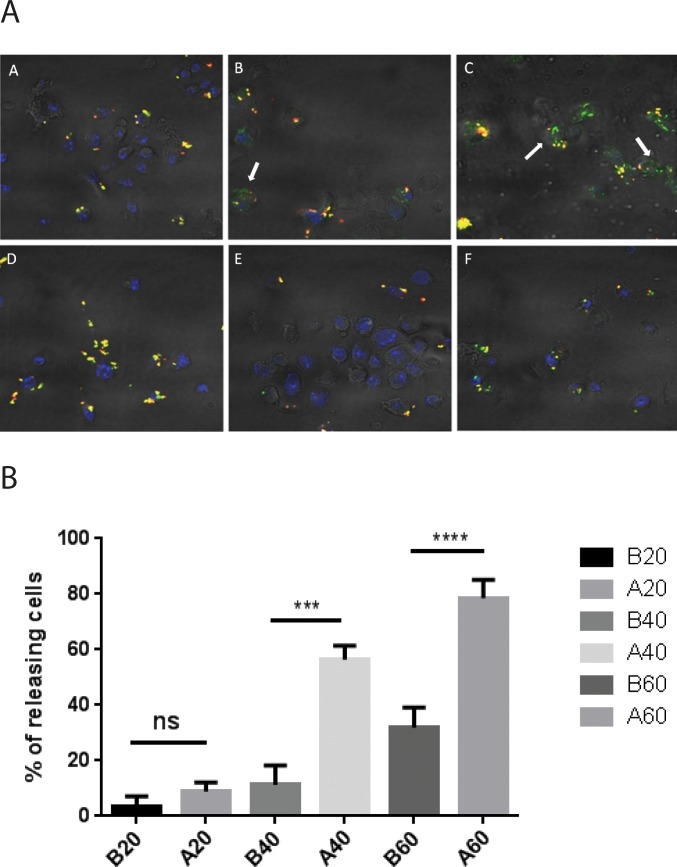
Cleavage of the disulfide bond allowed the release of conjugated FAM-SIINFEKL peptide from MIS416 in the cytoplasm of DCs.A) Confocal microscopy was used to analyse BMDCs treated with MIS416 conjugate A1 (MIS416-biotin-SAV-biotin-SS-SIINFEKL-FAM) and B1 (MIS416-biotin-SAV-biotin-ttds-SIINFEK-FAM). The top three panels (A, B, C) show fluorescent images of BMDC treated with conjugate A1 while the lower panels (D, E, F) are of BMDC treated with conjugate B1. Panels A and D represent BMDCs photographed immediately following washing with PBS to remove excess MIS416 conjugates from the medium after 20 min of uptake. B and E represent BMDCs photographed 20 min after washing, while C and F represent BMDCs photographed 40 min after washing. Yellow staining represents co-localisation in BMDCs of SAV-APC-labelled MIS416 with SIINFEKL-FAM. Red staining represents SAV-APC-labelled MIS416 in BMDCs. Green staining represents SIINFEKL-FAM (white arrows) released from MIS416 in BMDCs, and blue staining represents the nuclei of the BMDCs stained with DAPI. B) Graph representing the percentage of releasing cells obtained from confocal microscopy. Cells in the images were scored if they contained at least 1 internalized microparticle (see Materials and Methods). The total number of cells counted for each condition was as follows: A = 24, B = 34, C = 66, D = 23, E = 78, F = 56. Error bars represent SEM.